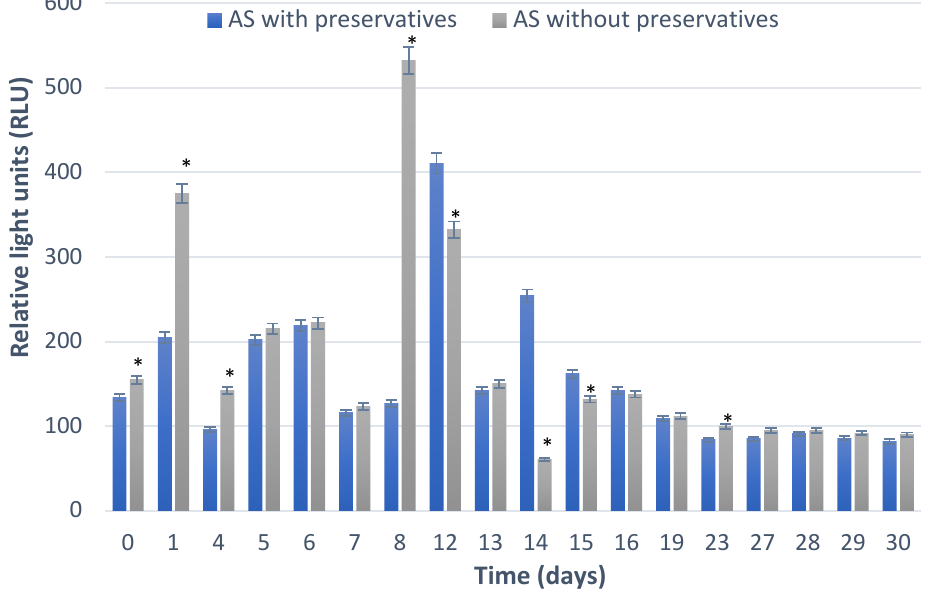
Figure 1. RLU mean values of aubergine salad with and without preservatives in relation to storage time, after incubation in Ringer solution; statistically significant differences ( p < 0.05) are marked with asterisk.